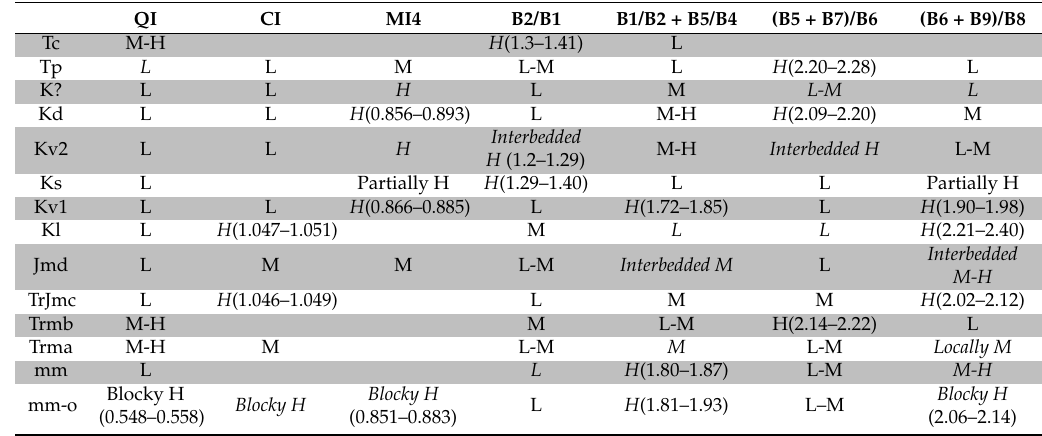
Table 2. Summary of relative band-ratio intensities of the mapping units in the study